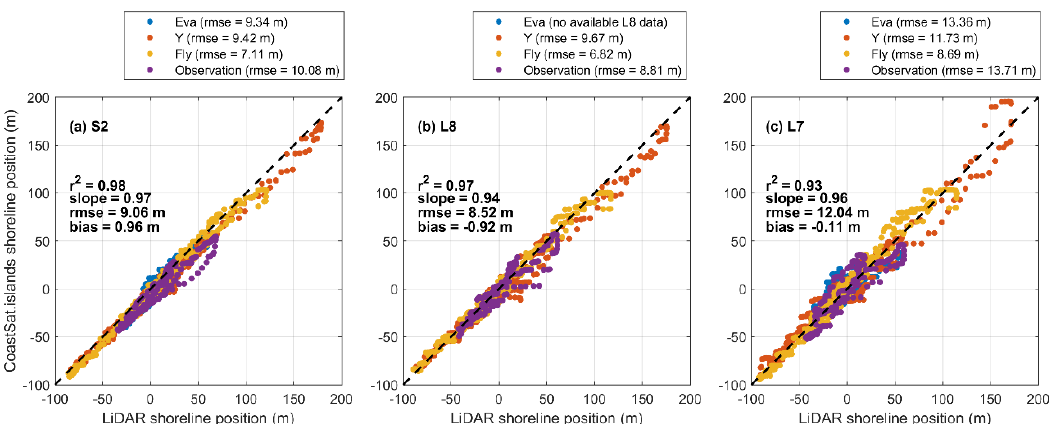
Figure 4. Validation of the ( a ) Sentinel-2, ( b ) Landsat-8, and ( c ) Landsat-7 satellite-derived shorelines versus airborne LiDAR survey. Total statistics (reported in black text) were calculated on the combined datasets (all islands) after the average shoreline position for each transect at each island was removed. Island-specific statistics are reported within the legend above each panel. In all panels, blue denotes Eva, orange denotes Y, yellow denotes Fly, and purple denotes Observation.